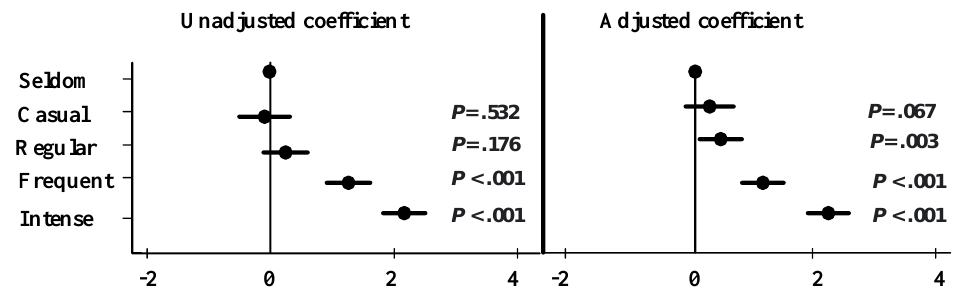
Figure 1 : Mean scores by gender of the physical health by internet use frequency in Bangladesh